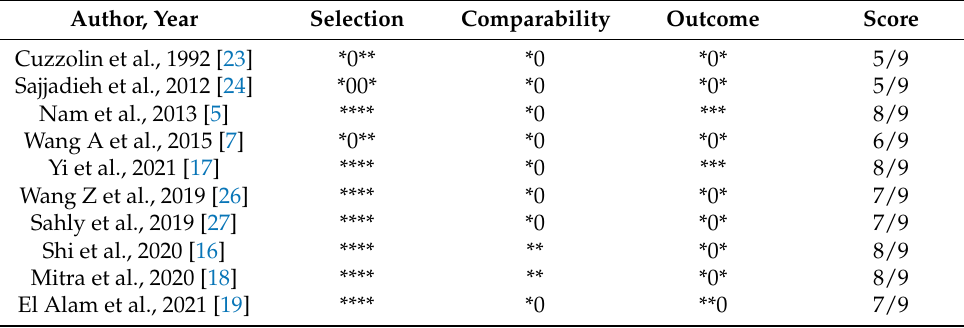
Table 5. Risk of bias—prospective cohorts.